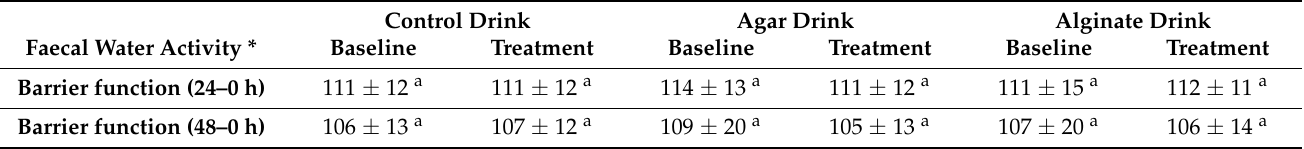
Table 4. Effect of consumption of control, agar, and alginate drink(s) on faecal water bioactivity.